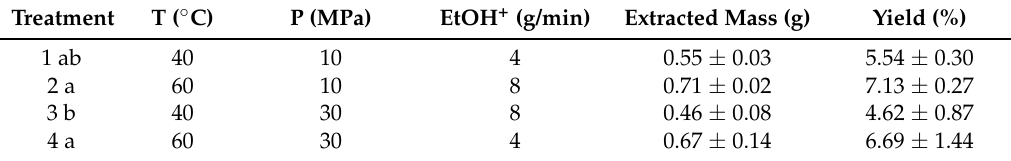
Table 1. Supercritical fluid extraction (SFE) conditions used for extractions and obtained